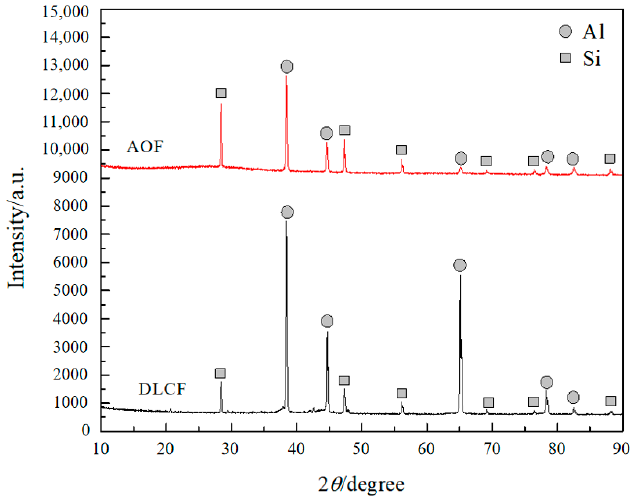
Figure 11. The surface morphology of DLC samples with the SEM: ( a ) 500 times; ( b ) 1000 times; ( c ) 2000 times.